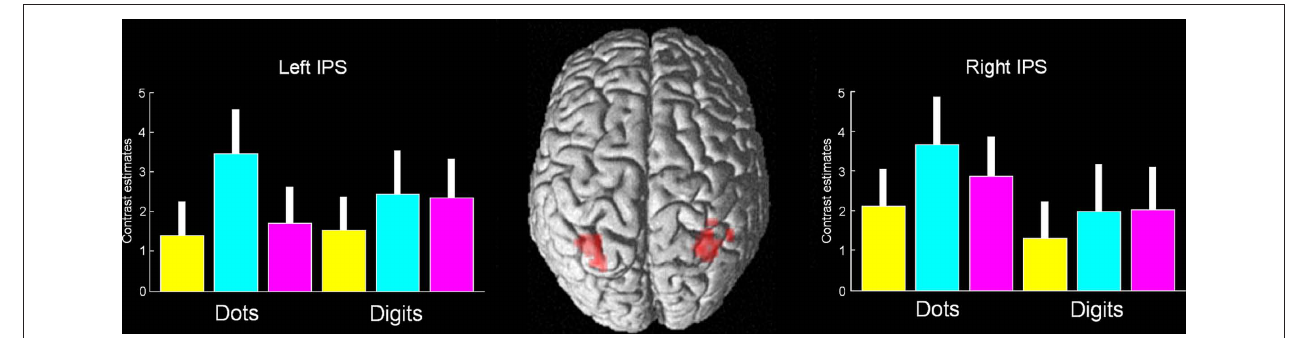
meta-analysis of magnitude and numerical representation (Cohen Kadosh et al., 2008). Magnitude change appears in yellow, format change in turquoise, and visuomotor change in magenta. Error bars represent 90% confidence intervals.